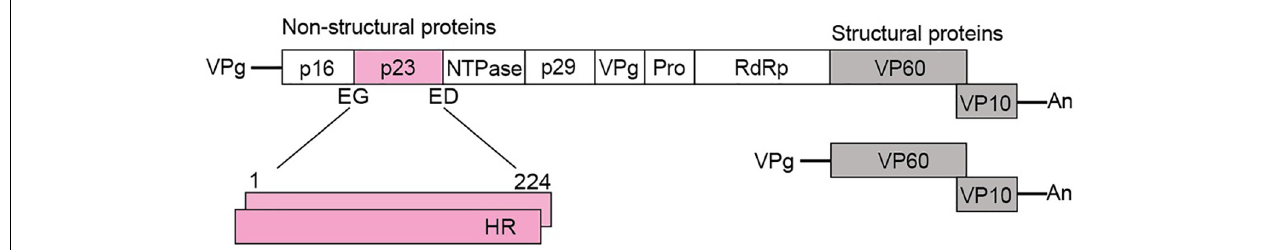
FIGURE 1 | Schematic representation of a typical lagovirus genome. Both genomic (Top) and subgenomic RNAs (Bottom) contain two ORFs, are covalently linked to the viral protein VPg at the 5 (cid:48) -end, and are polyadenylated at the 3 (cid:48) -end (An). The genomic RNA encodes non-structural (shown in white and pink) and structural proteins (shown in gray), whereas the subgenomic RNA encodes only structural proteins. The coding sequence for p23 (224 amino acid residues) is shown in pink; two copies are shown to indicate that p23 dimerizes; cleavage sites at the N-terminus (E, glutamine and G, glycine) and C-terminus (E, glutamine and D, aspartic acid) are indicated; HR, hydrophobic